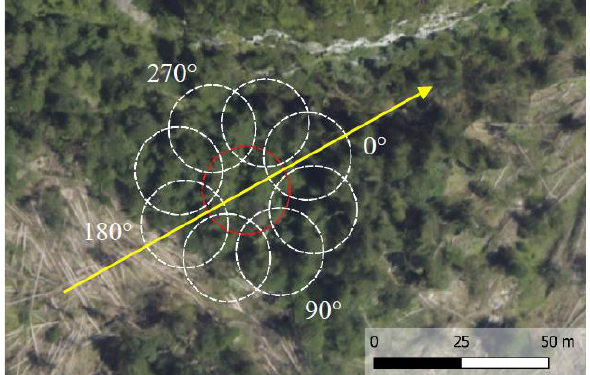
Figure 7. In red the original footprint, and shifts of the hypothetical location. Yellow arrow is the orbit direction.